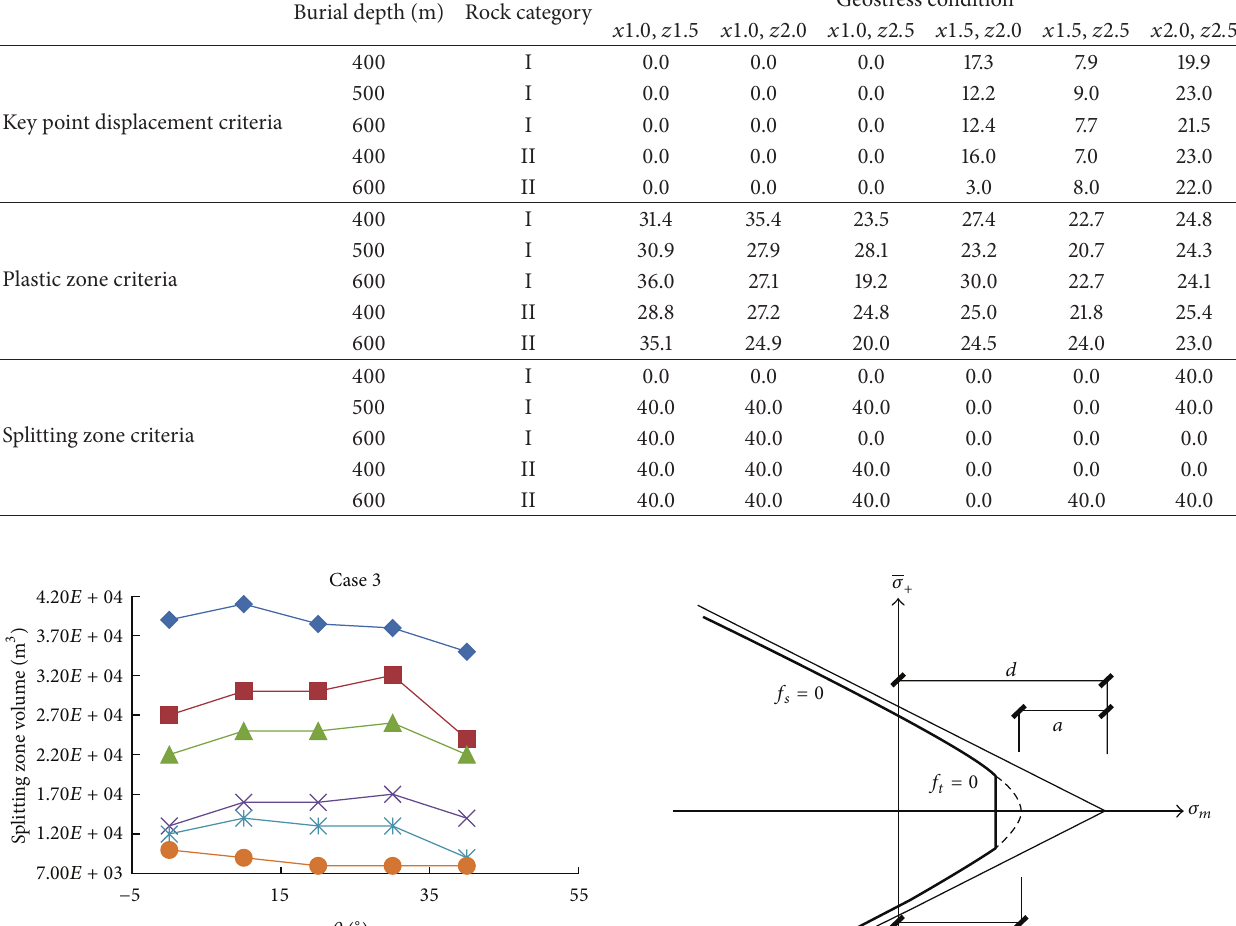
Table 7: The most favorable angle 𝜃 for the underground cavern stability (degree: ∘ ). Burial depth (m) Rock category